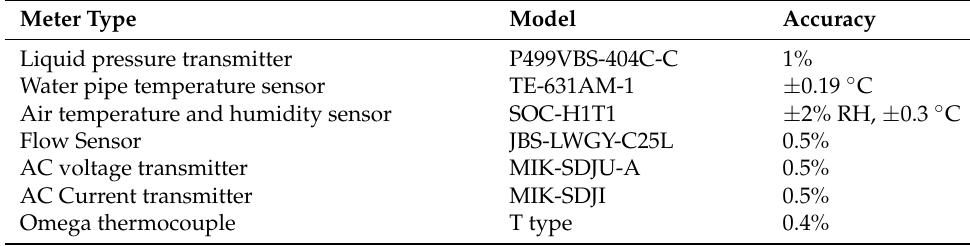
Table 1. Measurement devices and